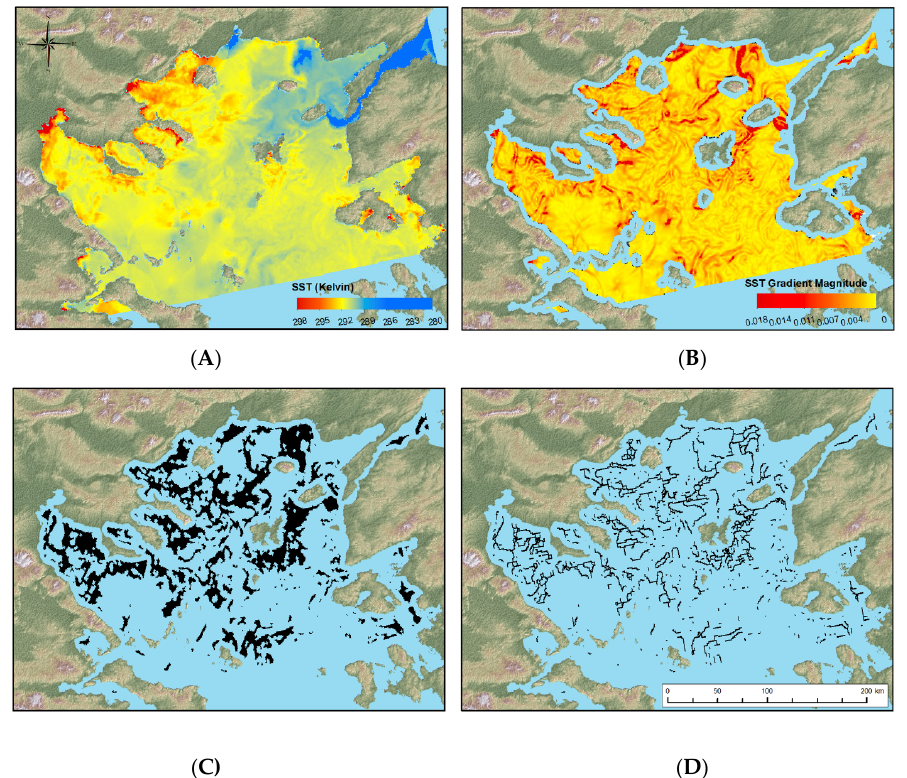
Figure 6. Results from 13/05/2020: ( A ) Interpolated SST data; ( B ) SST Gradient Magnitude; ( C ) Binary Image after threshold application and morphological closing; ( D ) Detected thinned oceanic features.